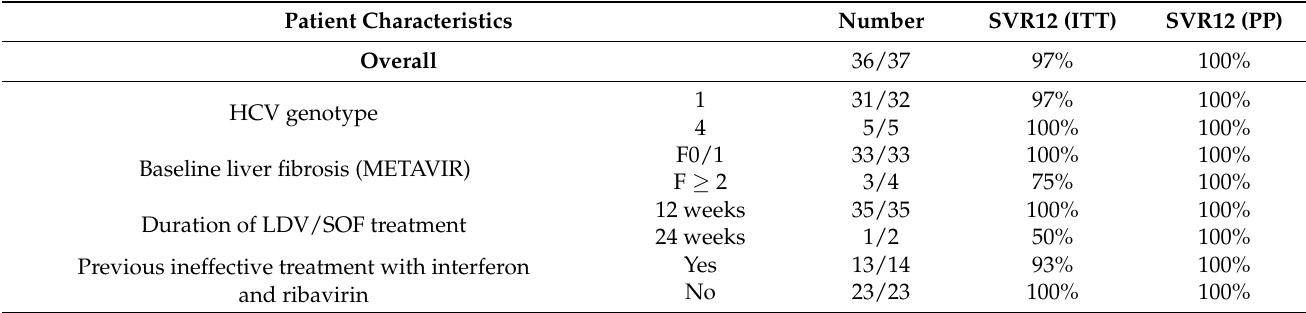
Table 2. Efficacy of LDV/SOF treatment in 37 adolescents with CHC (intention-to-treat and per-protocol analysis). Patient Characteristics